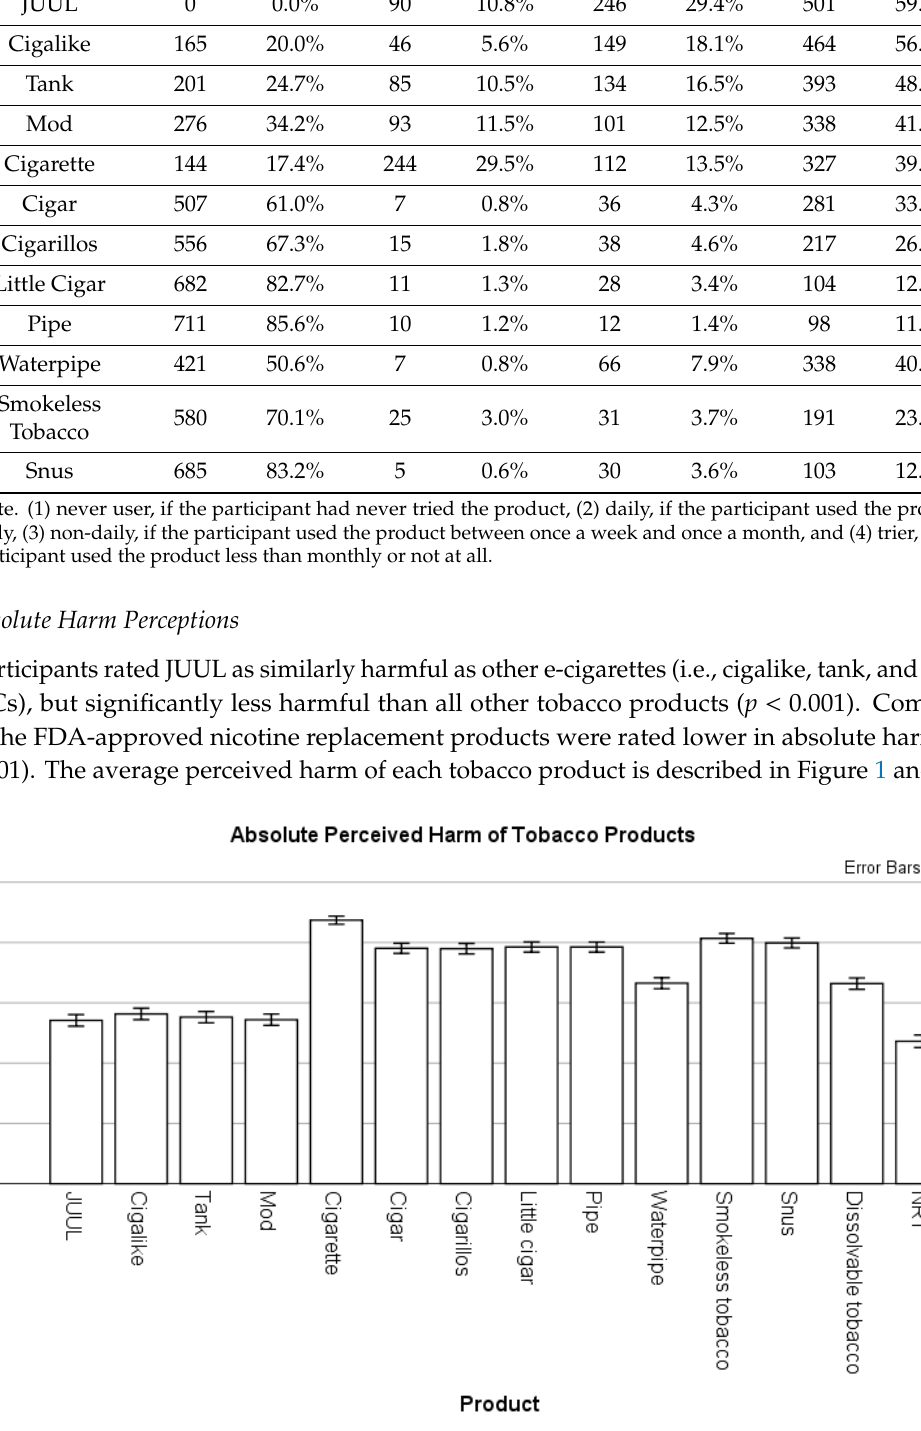
Table 1. Frequency of JUUL use and other tobacco products.